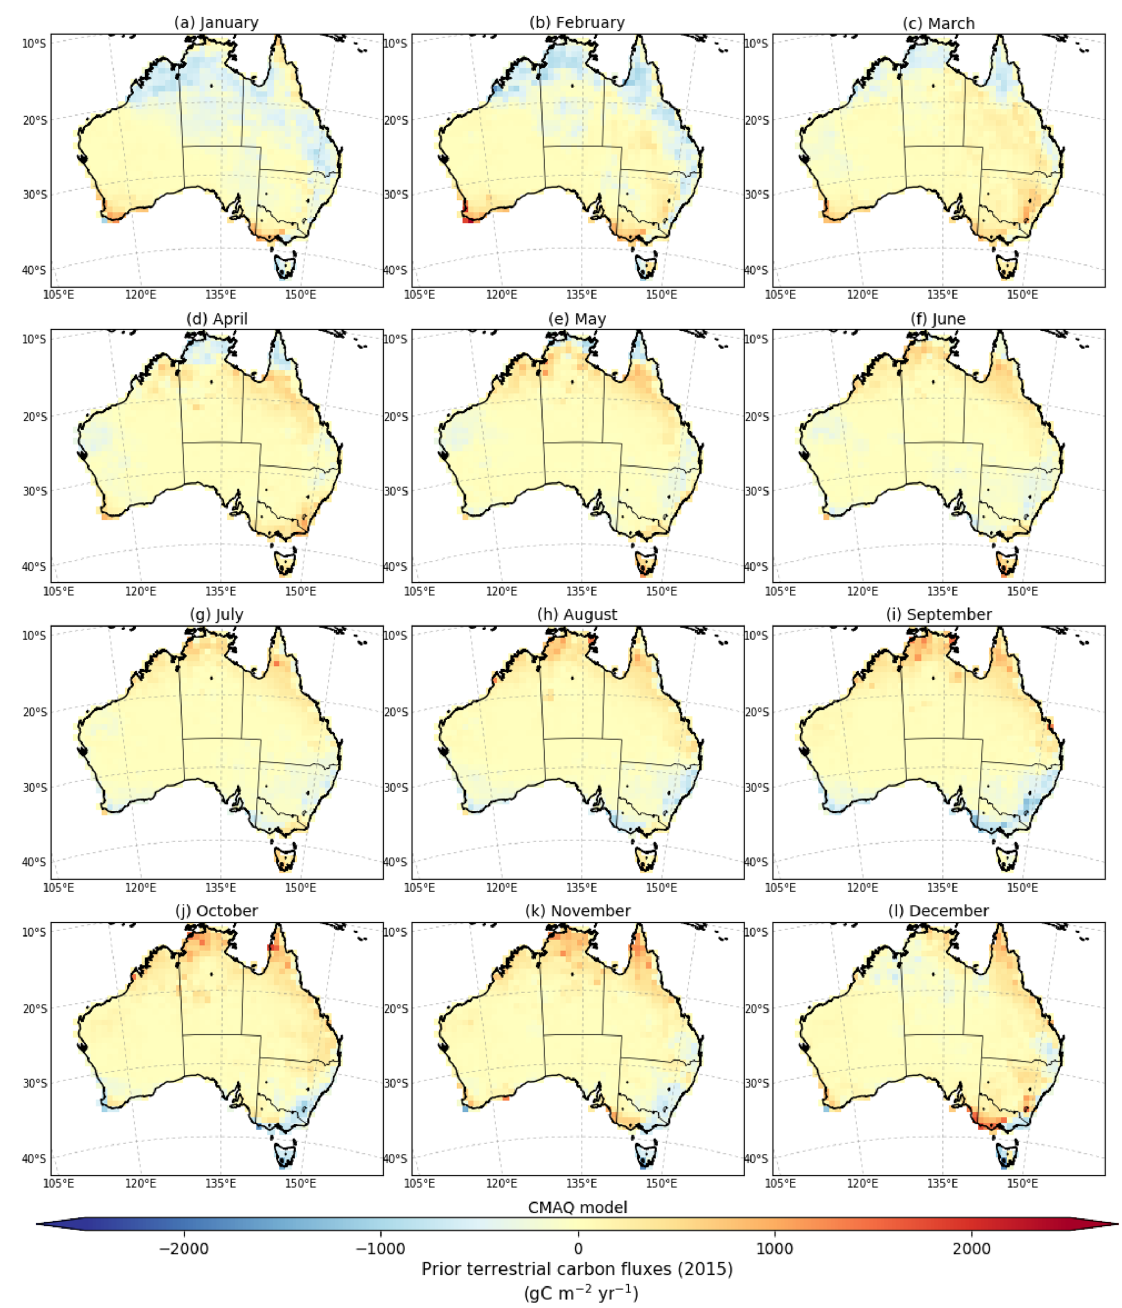
Figure 6. Prior fluxes derived by the CABLE model in the BIOS3 setup in combination with fires emissions selected by GFED for 2015 (fossil fuel emissions are